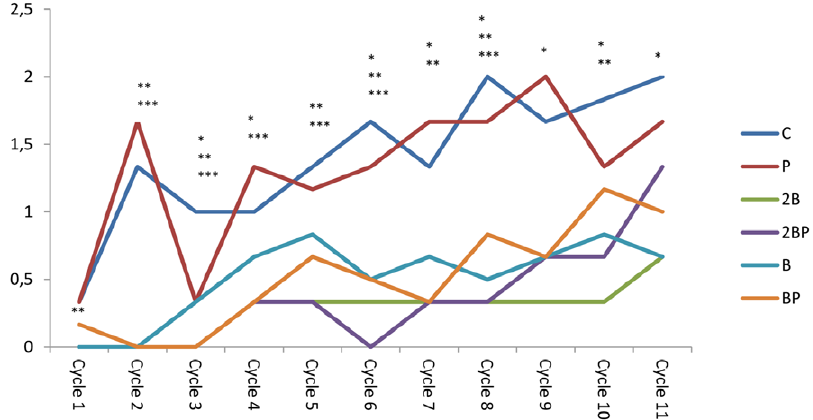
Figure 1. Disease activity index. Disease activity index (DAI) during the 11 cycles of DSS administration. DAI scores are expressed as medians (25 and 75 percentiles). Significant differences are expressed versus the C group. Cycle 1: **P , 0.01 for groups 2B, 2BP and B; Cycle 2: **P , 0.01 for groups B and BP, *** P , 0.001 for groups 2B and 2BP groups; Cycle 3: *P , 0.05 for group P, **P , 0.001 for group B group, ***P , 0.001 for groups 2B, 2BP and BP; Cycle 4: *P , 0.05 for group BP, ***P , 0.001 for groups 2B and 2BP; Cycle 5: **P , 0.01 for group B group, ***P , 0.001 for groups 2B, 2BP, and BP; Cycle 6: *P , 0.05 for group B, **P , 0.01 for group BP,***P , 0.001 for groups 2B and BP; Cycle 7: *P , 0.05 for group B, **P , 0.01 for groups 2B and B, ***P , 0.001 for groups 2BP and BP; Cycle 8: *P , 0.05 for group BP, **P , 0.01 for groups 2B and B, ***P , 0.001 for group 2BP; Cycle 9: *P , 0.05 for groups 2B, 2BP, B, BP; Cycle 10, *P , 0.05 for group B, **P , 0.01 for groups 2B and 2BP; Cycle 11: *P , 0.05 for groups 2B, 2BP, B, BP.